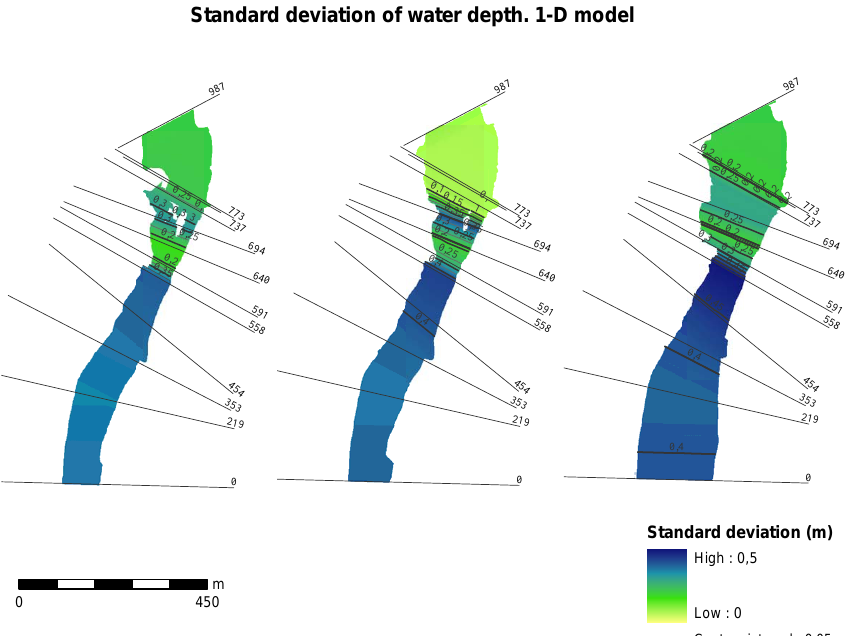
Fig. 13. 1-D HEC-RAS model. Flood maps with standard deviation values of water depth predicted by point-estimate method for flow cases of 200m 3 s − 1 (left panel), 300m 3 s − 1 (middle panel) and 500m 3 s − 1 (right panel).